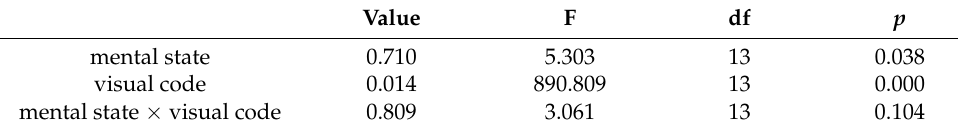
Table 4. Multivariate ANOVA results for reaction times of mental state and visual code.